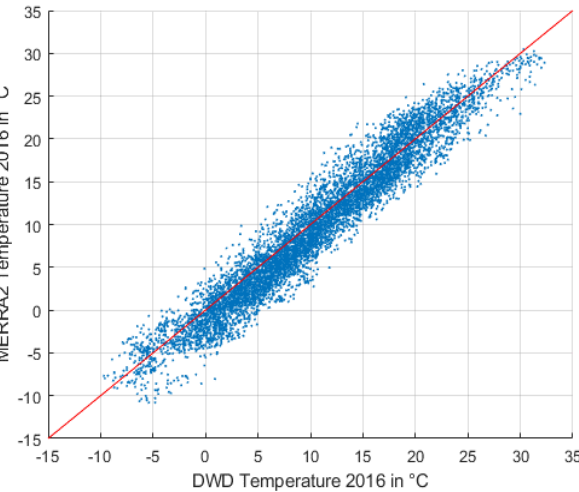
Figure 8. Scatter diagram of surface temperature (TS) for DWD and MERRA-2 in 2016 in Bremen.